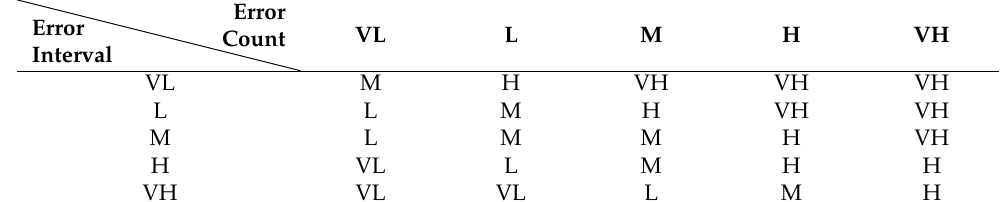
Figure 7. Membership functions for Guard. Table 6. Fuzzy rules table.